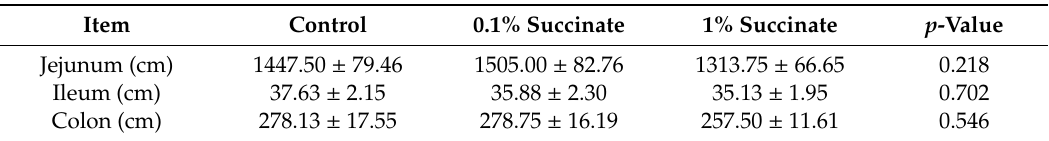
Figure 1. Histological evaluation of jejunal tissues from pig fed with basal, 0.1% succinate, and 1% succinate diet by hematoxylin and eosin (H&E)-staining. The yellow arrows denote villi length. The black arrows denote crypt depth. Table 2. Effects of diet sodium succinate supplementation on the length of different intestinal segments in growing pigs.